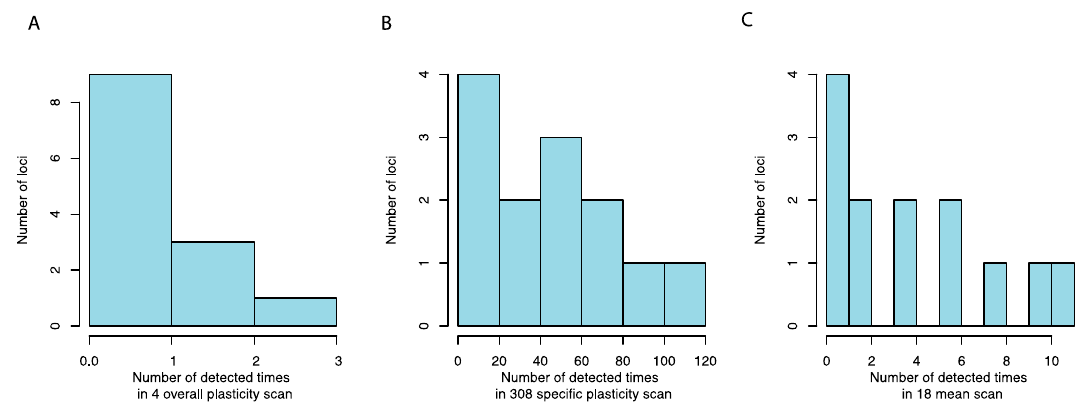
Figure 4. The detection frequency for hub loci in mean and plasticity GWA scan. The number of times the 13 previously detected epistatic hub-loci in growth networks of this population [19] were mapped